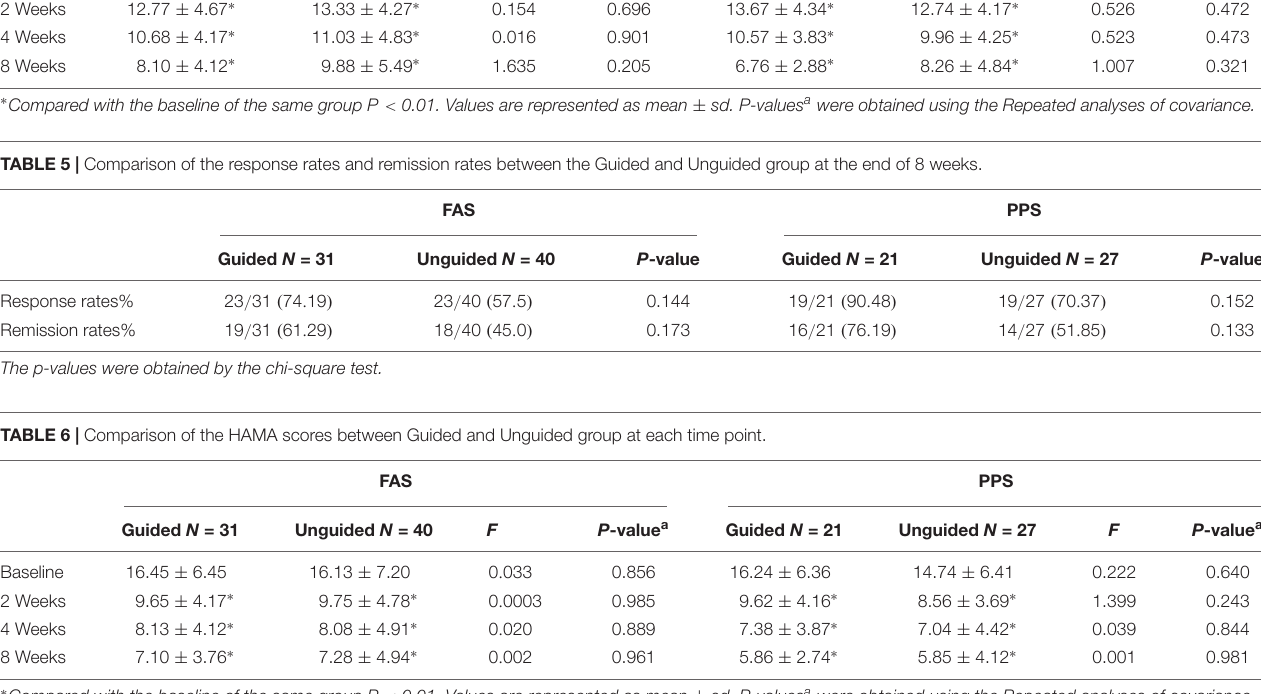
TABLE 4 | Comparison of the HAMD scores between Guided and Unguided group at each time point. FAS PPS Guided N = 31 P -value a Guided N = 21 F P -value a